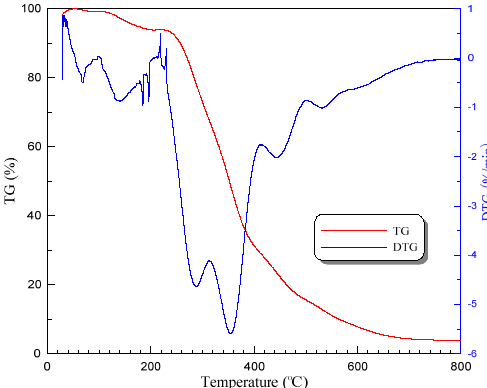
Figure 4. Thermogravimetric and derivative thermogravimetry curves of PVA fiber used.